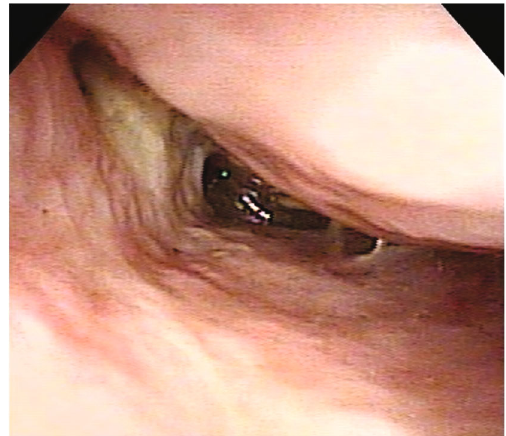
Figure 4: Endoscopic image (7 days after endoscopic cauterization hemostasis). Scarring of the nasal mucosa at the bleeding point is